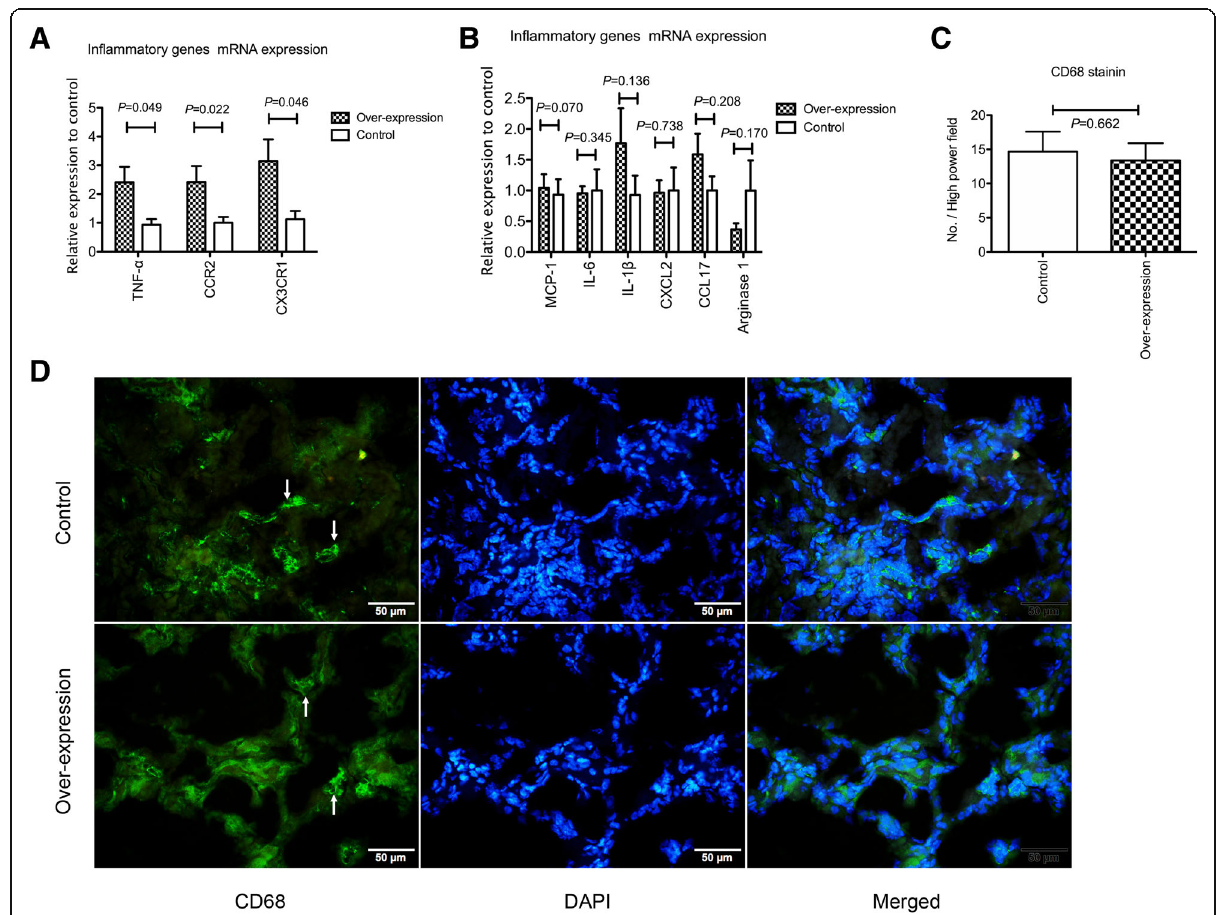
Fig. 9 a & b Inflammatory genes expression 1 day after IRI in the whole kidney. The mRNA expression of TNF- α , CCR2 and CX3CR1 was higher in the over-expression than control mice. The gene expression of MCP-1, IL-6, IL-1 β , CXCL2, CCL17 and arginase 1 did not differ between the over- expression and control mice. ( N = 8 per group) c & d CD68 positive cells infiltration 1 day after IRI in the kidney. The infiltration of CD68 positive cells was not different between the over-expression and control mice. Arrow indicates CD68 positive cells ( N = 6 per